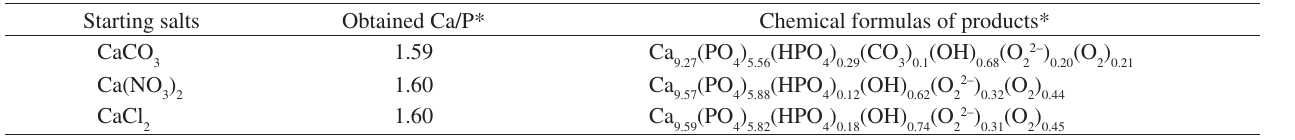
Table 1. Results of the chemical analysis of prepared apatites. Starting